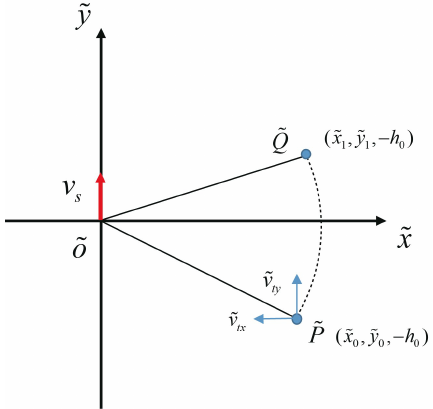
Figure 5. Top view of radar coordinate